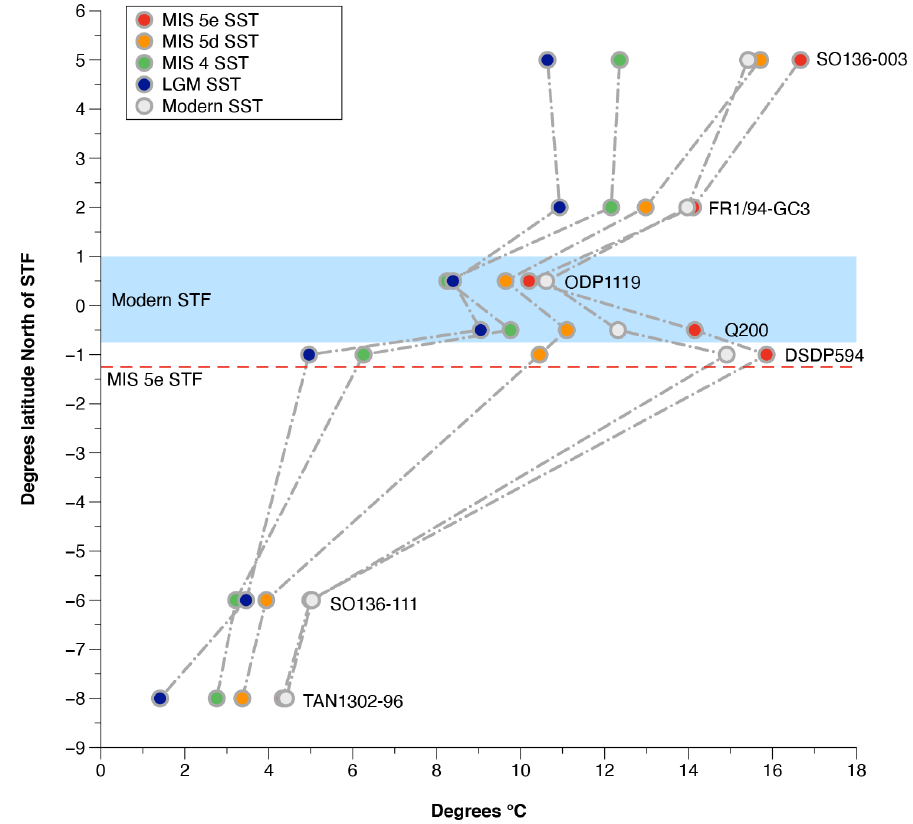
Figure 6. SST estimates from seven cores located in the southwestern Pacific. SST used were five-point averages (depending on sampling resolution) taken at MIS peaks and median dates in accordance with boundaries outlined in Lisiecki and Raymo (2005). Due to the complex circulation and frontal structures in the region, cores were plotted in ± distance from the average position of the modern STF. Cores used include SO136-003 (SSTs calculated from alkenones, Pelejero et al., 2006), FR1/94-GC3 (alkenones, Pelejero et al., 2006), ODP 181-1119 (PF-MAT, Hayward et al., 2008), DSDP594 (PF-MAT, Schaefer et al., 2005), Q200 (PF-MAT, Weaver et al., 1998), SO136-111 (D-MAT, Crosta et al., 2004), and TAN1302-96 (D-MAT; this study). The blue band represents the modern STF zone, while the red dotted line represents the southern shift in the STF during MIS 5e (Cortese et al.,